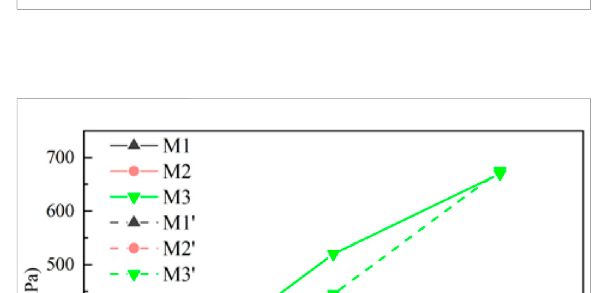
FIGURE 20 Axial stress of pipeline central section with different compactness